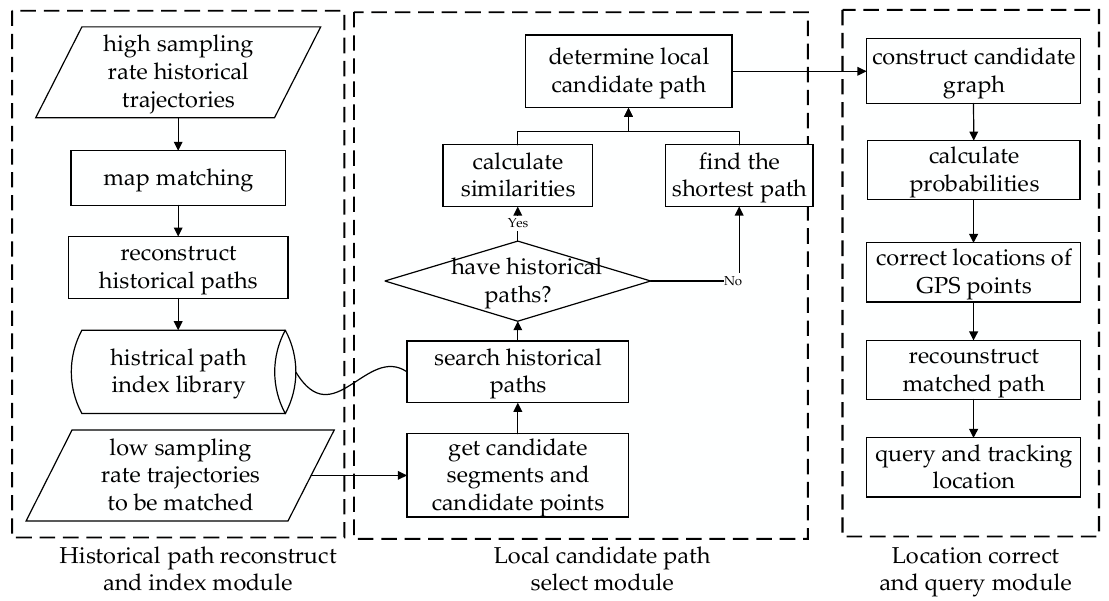
Figure 2. Framework of HTMM. HTMM is made up of three modules: a historical path reconstruc- tion and index module, a local candidate path selection module, and a location correction and query module.